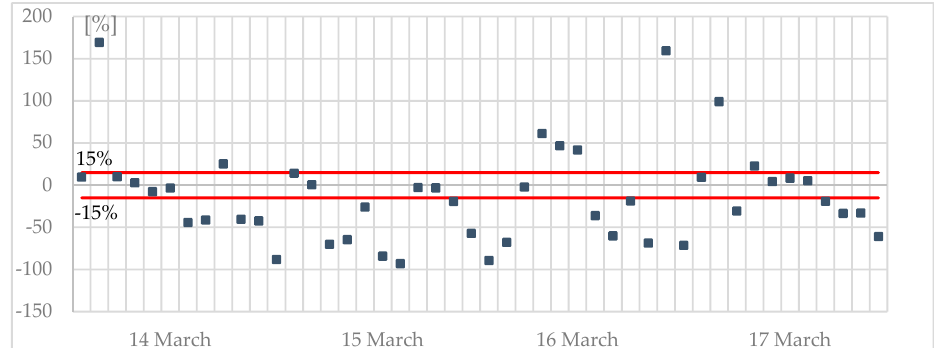
Figure 5. Percentage error on non-clear sky days.